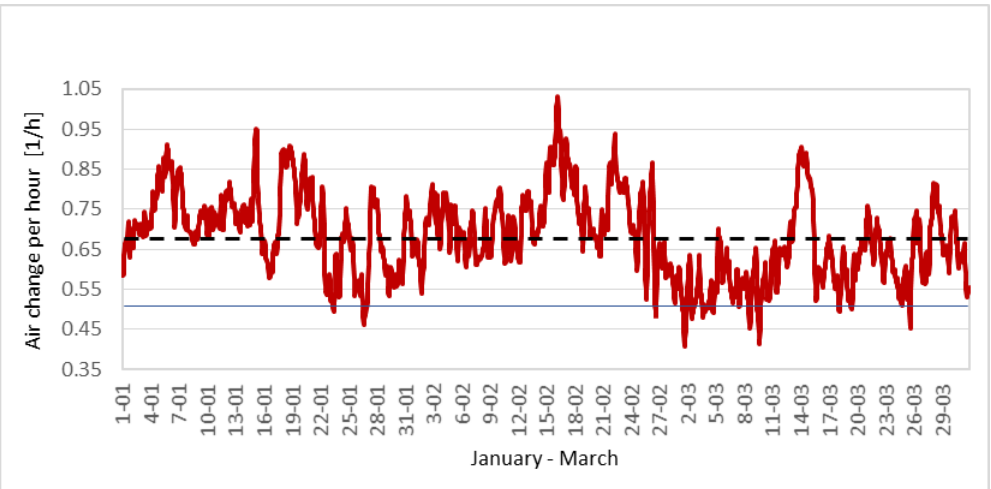
Figure 13. Simulated air change intensity in the period January-March. Assumed characteristic air flow rate n = 0.45 1/h. The dashed line corresponds to the mean value and the continuous line to hygienic minimum n = 0.506 1/h.